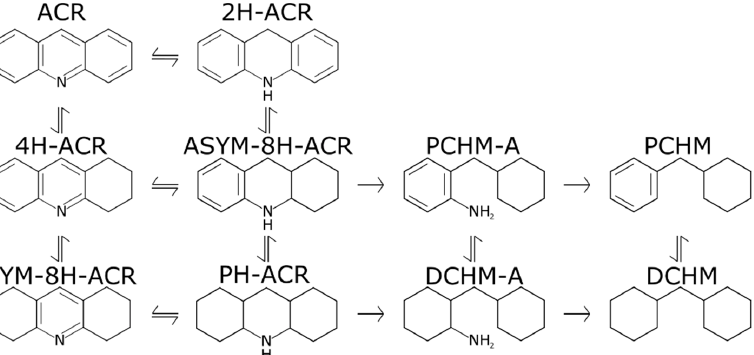
Figure 8. HDN network of acridine to its HDN products: 9,10-dihydroacridine (2H-ACR), 1,2,3,4- tetrahydroacridine(4H-ACR), 1,2,3,4,4a,9,9a,10-octahydroacridine (ASYM-8H-ACR), 1,2,3,4,5,6,7,8- octahydroacridine (SYM-8A-ACR), perhydroacridine (PH-ACR), phenylcyclohexylmethaneamine (PCHM-A), dicyclohexylmethaneamine (DCHM-A), phenylcyclohexylmethane (PCHM), and dicyclo- hexylmethane (DCHM).